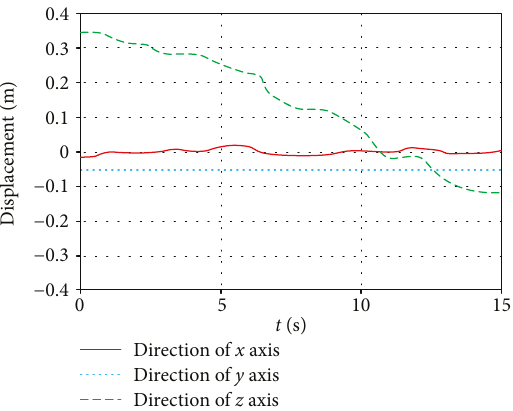
Figure 17: Motion simulation of the center of gravity displacement change with time in triangular